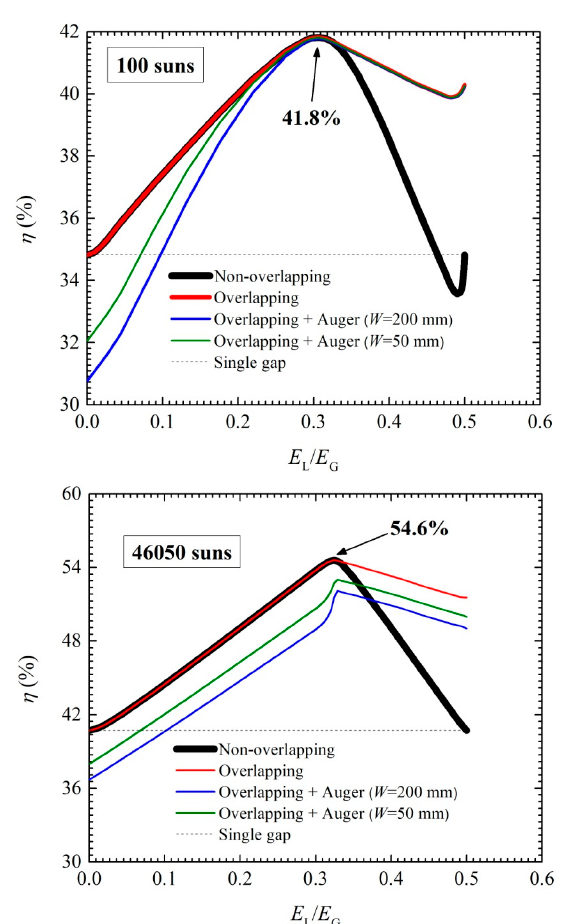
Figure 4. Limit e ffi ciency of silicon IBSC at 100 ( top ) suns and 46,050 suns ( bottom ) for di ff erent IB positions with and without overlapping and with and without Auger recombination (discussed in Section 3.3). The value of γ is optimized to maximize the e ffi ciency at every E L and the limit e ffi ciency of a conventional silicon solar cell is shown for